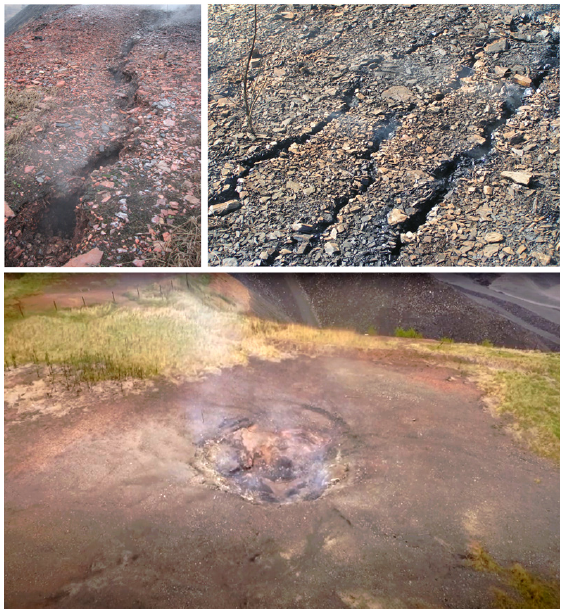
Figure 7. Exhalation fissures and a sinkhole in the fire zones of the Szarlota dump in Rydułtowy (Photos by Z. Ró ż a ń ski).